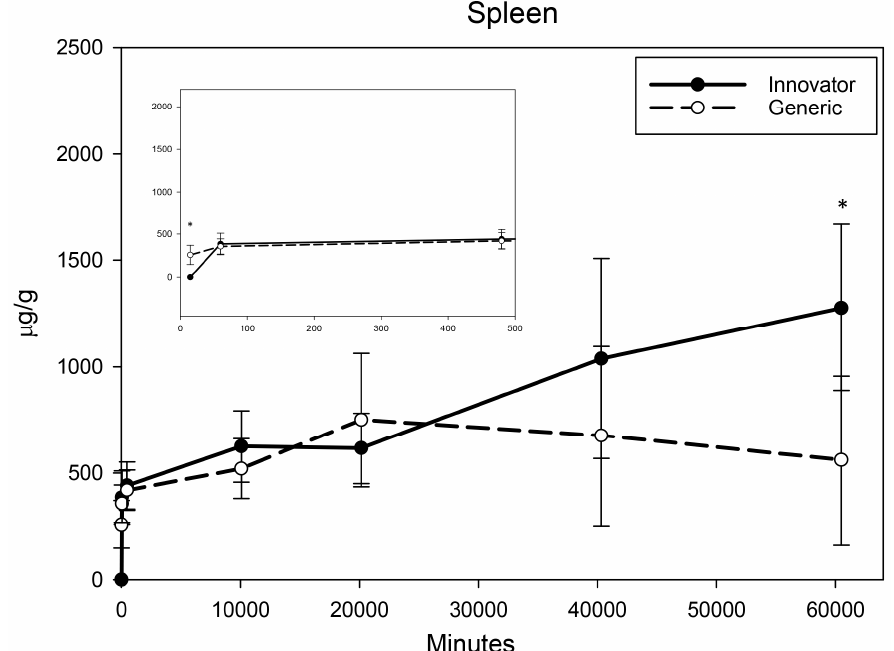
Figure 8. Spleen mean iron concentrations over time. Endogenous (control) iron concentration was subtracted from both the innovator (solid) and the generic (dashed). Negative results are not graphed. Time points = 15 min, 60 min (1 h), 480 min (8 h), 10,080 min (1 week), 20,160 min (2 weeks), 40,320 min (4 weeks), 60,480 min (6 weeks). Inset shows the first three time points (15 min, 1 h, 8 h). Values are shown as mean + SD; n = 6 per group per time point; * p < 0.05.